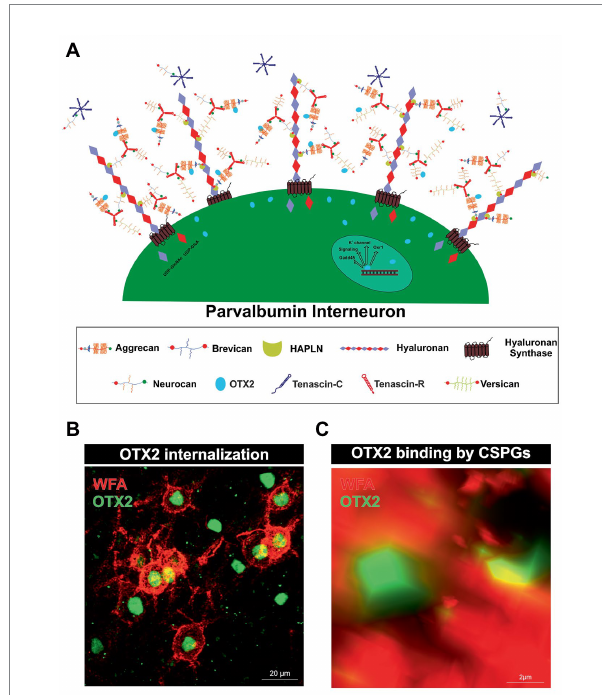
FIGURE 1 Internalization of OTX2 by Parvalbumin interneurons mediated by PNNs. (A) Scheme of PNN surrounding a parvalbumin interneuron. PNNs consist of a hyaluronan backbone, which interacts with lecticans and link proteins of the hyaluronan and proteoglycan binding link protein family (HAPLN) and forms the ternary complex. The lecticans aggrecan, brevican, neurocan, and versican, in turn can bind trimeric tenascin-R to their G3 domain and form